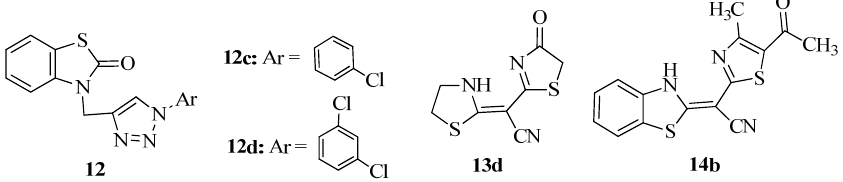
Figure 6. Structures-bromobenzo[d]thiazol-2(3H)-one derived 1,2,3-triazole derivatives ( 12 )